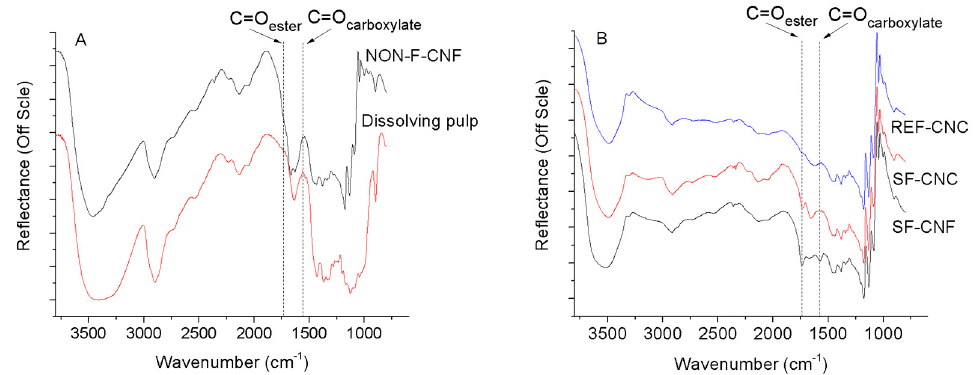
Figure 6. DRIFT spectra for pure dissolving cellulose pulp and non-functionalized CNF ( A ) and cellulosic nanoparticles REF-CNC, SF-CNC and SF-CNF ( B ). The most distinct bands are numbered and presented as dashed lines: 1730 cm − 1 is associated with C=O stretching in the carboxylic acid and ester groups, and 1574 cm − 1 is associated with the C=O stretching of carboxylate anions.